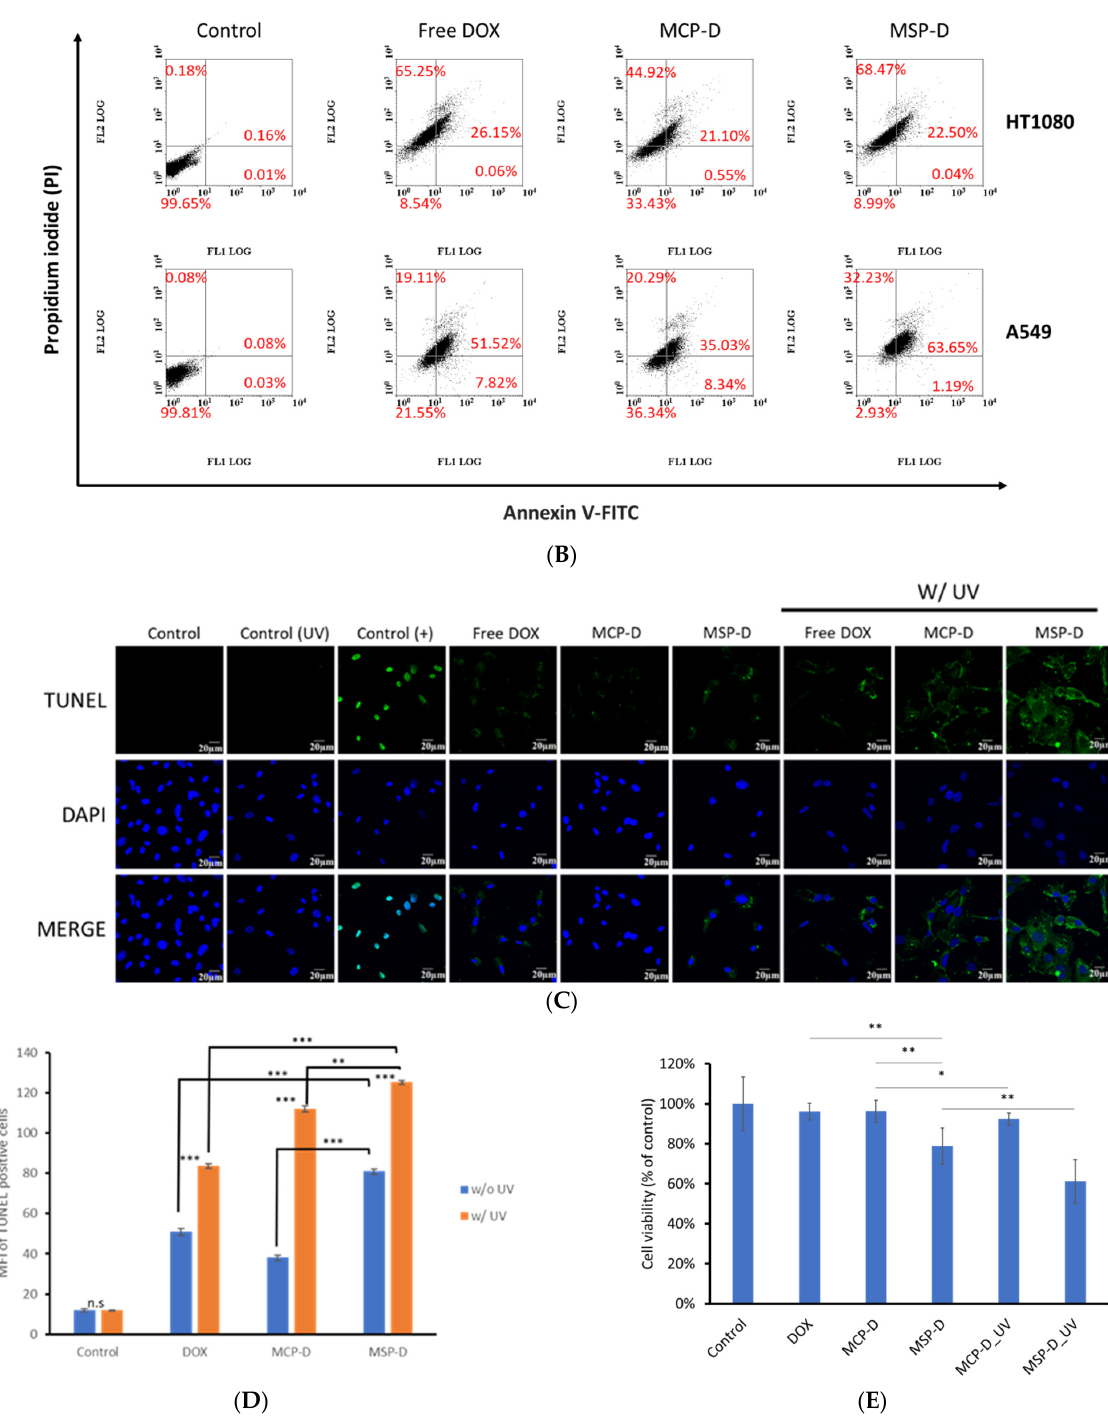
Figure 6. Confocal images of HT1080 cells exposed to test samples with and without UV light irradiation. Red: fluorescence of doxorubicin (DOX), blue: nuclei stained by 4',6-diamidino-2-phenylindole (DAPI). Scale bar is 20 µm ( A ); Annexin-V/PI (propidium iodide) dual-staining apoptotic assay by flow cytometry ( B ) and TUNEL apoptotic assay of HT1080 cells by CLSM, blue: nuclei stained by DAPI, green: apoptotic cells ( C ); control (UV) means cells treated with UV light and control (+) means cells treated with DNase 1. Mean fluorescence intensity (MFI) of (C) analyzed using ImageJ software ( D ); cytotoxicity of HT1080 cells exposed to free DOX, MCP-D, and MSP-D at an equivalent DOX concentration of 1 µ g/mL for 4 h with and without UV light irradiation for 10 min ( E ) (* p < 0.05, ** p < 0.005, *** p <